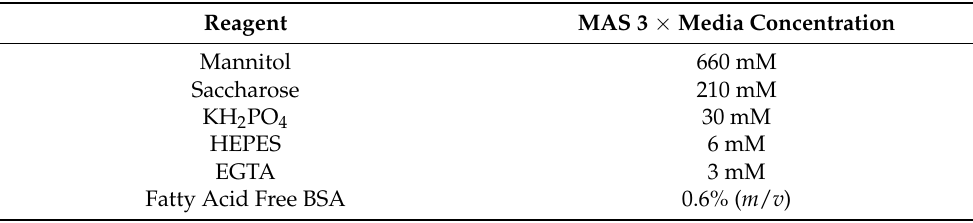
Table 1. Reagents used for the preparation of the MAS test